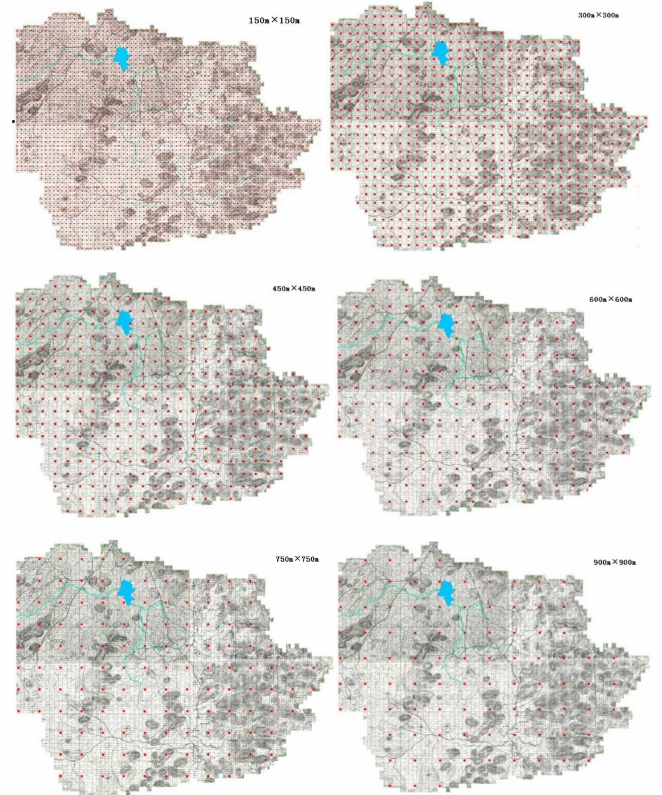
Figure 2. Plots of soil sample distribution under different sampling